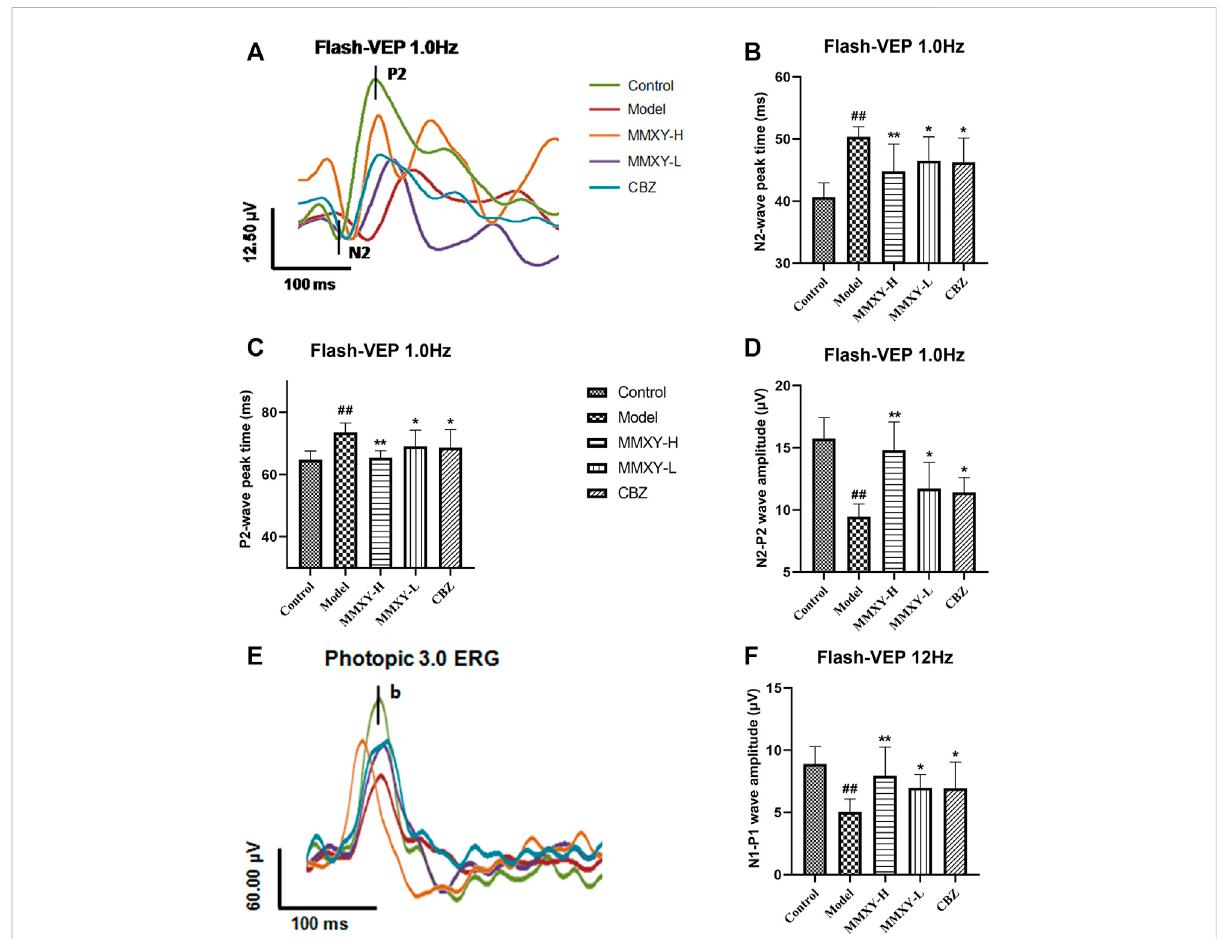
FIGURE 8 Effects of MMXY on VEP of CUMS rats in each group. (A) The waveform curve of Flash-VEP 1.0 Hz. (B,C) N2 and P2 Peak times of Flash-VEP 1.0 Hz (n = 8 eyes). (D) The N2-P2 wave amplitude of Flash-VEP 1.0 Hz (n = 8 eyes). (E) The waveform curve of Flash-VEP 12 Hz. (F) The N1-P1wave amplitudeofFlash-VEP12 Hz(n=8eyes).Resultsareshownasthemean±SD. # p < 0.05and ## p < 0.01vs.controlgroup;* p < 0.05and** p < 0.01vs. model